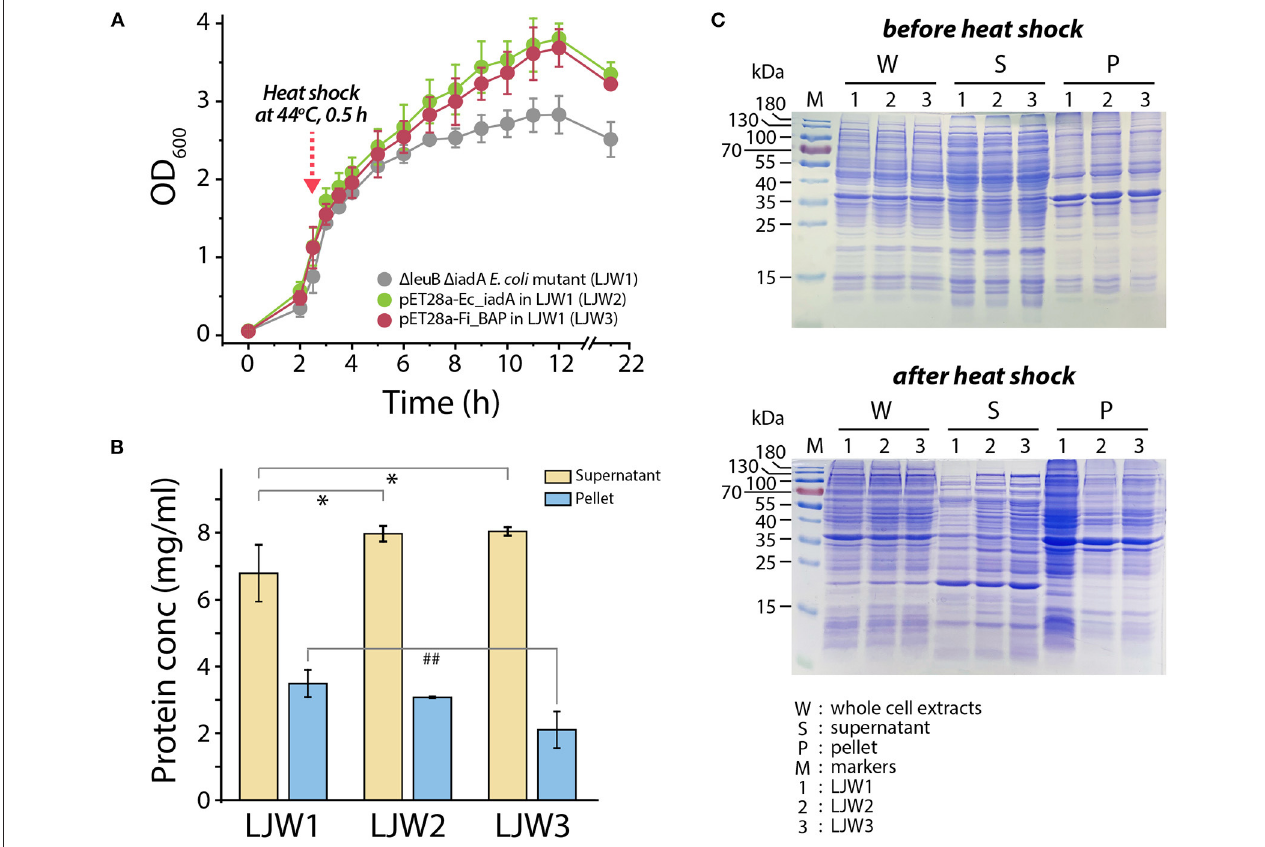
FIGURE 7 | Bacterial growth and protein pattern analysis after heat treatment. (A) Growth curve of E. coli mutant strains (LJW1, LJW2, and LJW3) in LB media at 37 ◦ C. Heat shock treatment was performed at 44 ◦ C for 30min when cells reached the mid-exponential phase (OD 600 of 1.0–1.5). (B) Quantification of soluble (supernatant) and insoluble (pellet) protein in heat-treated cells. Group differences were assessed using one-way analysis of variance (ANOVA), followed by LSD test (* p < 0.05 vs. WT supernatant and ## p < 0.01 vs. WT pellet). (C) Comparison of whole protein, soluble (supernatant) protein, and insoluble (pellet) protein in heat-treated and non-heat-treated cells by SDS-PAGE